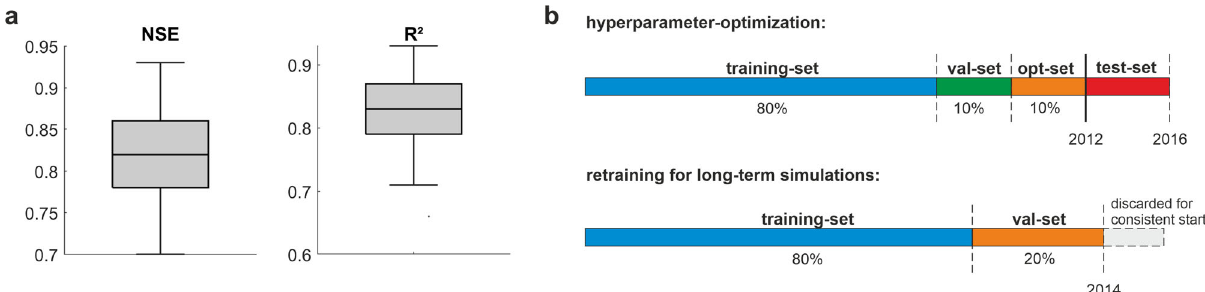
Fig. 7 Overall model performance and data splitting scheme. a Model performance of all models for the test-set (2012 – 2016). b Time series splitting scheme for optimization (upper) and